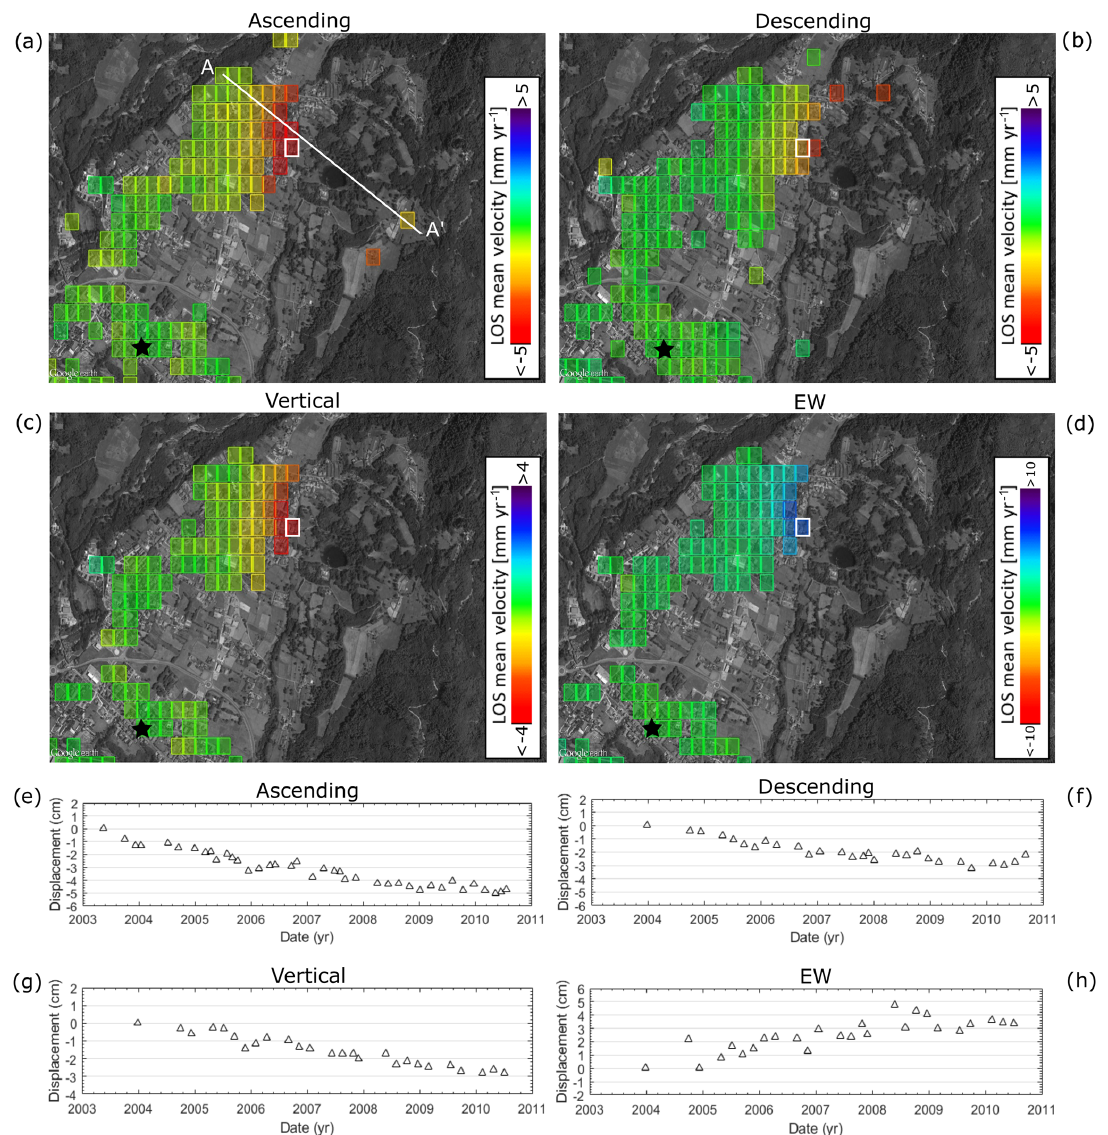
Figure 4. (a, b) Maps of average surface velocity and its vertical (c) and east–west (d) components obtained from ENVISAT SAR images acquired between 2003 and 2010. Negative values indicate a range increase. The white line in panel (a) marks the cross section shown in Fig. 4. The black star is the point used as a reference for the InSAR-SBAS processing. (e–h) Time series of incremental deformation extracted from the pixel bounded with the white